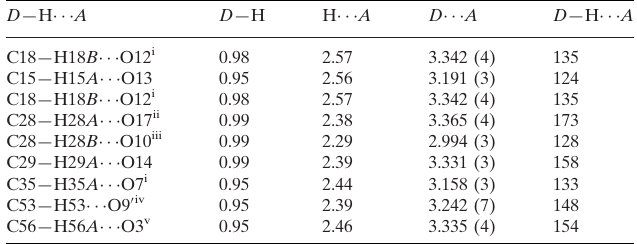
Hydrogen-bond geometry (A˚ , (cid:3)